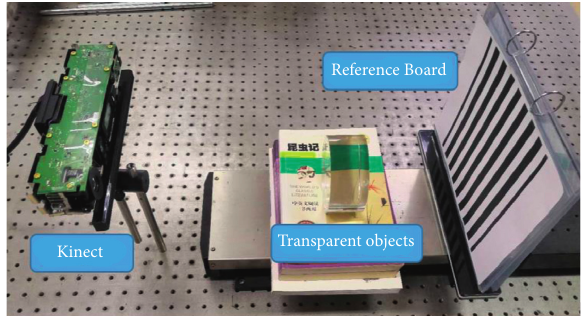
Figure 7: Experimental